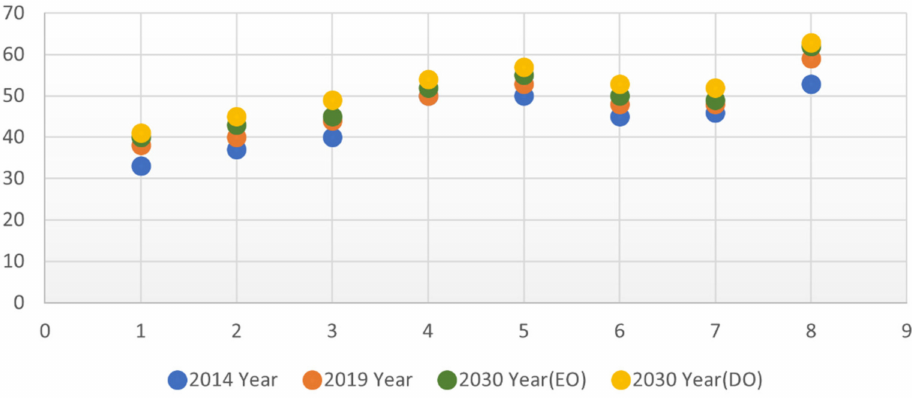
Figure 10. Changes in the ecological effects of land use in various townships from 2013 to